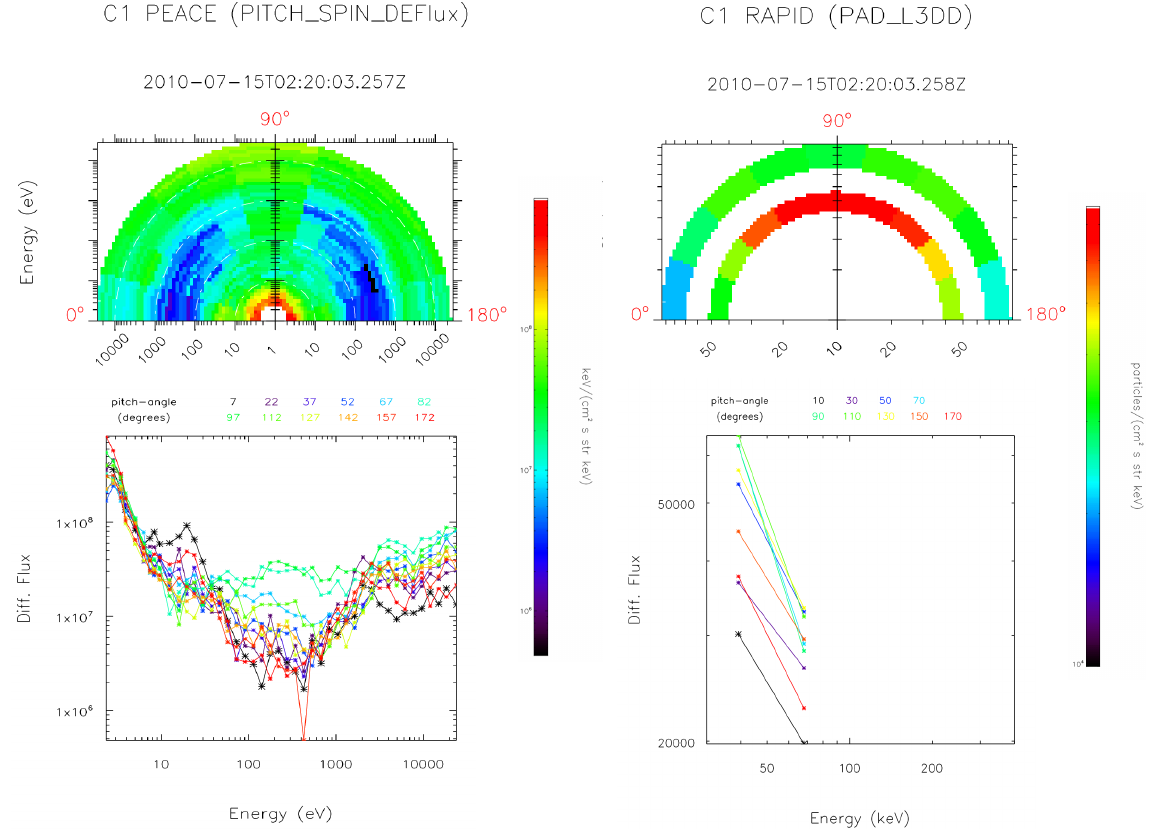
Figure 4. Equatorial distribution functions of a typical chorus event observed on 15 July 2010 onboard Cluster C1 at L ≈ 5. Top panels present the electron wheel plots (distribution of pitch angle as a function of energy) measured by PEACE (upper-left panel) and RAPID (upper-right panel) instruments. Bottom panels show the electron differential fluxes (the different pitch angle ranges are colour-coded) as a function of energy observed during this event by the same instruments. These observed values are used to compute the electron distribution functions in our